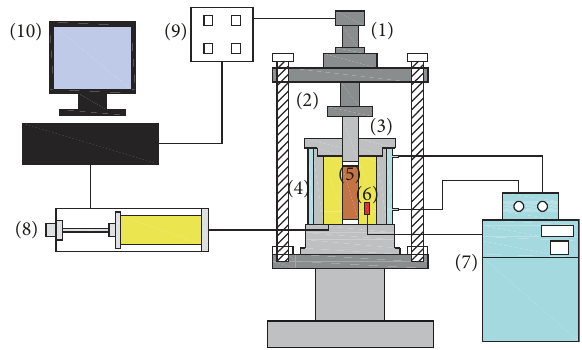
Figure 2: Triaxial creep test system for frozen soil. (1) Axial loading cell; (2) antiforce frame; (3) pressure cell; (4) cryogenic coolant; (5) specimen; (6) thermocouple; (7) thermostatic bath; (8) confining pressure controller; (9) axial loading controller; (10)